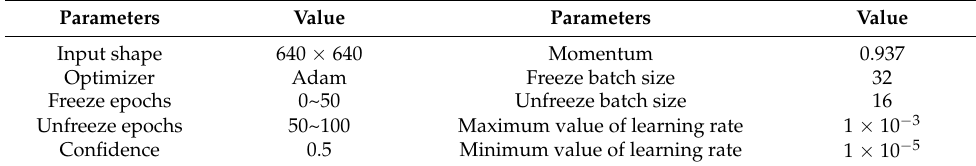
Table 2. The parameters settings for network